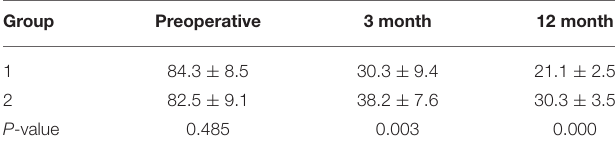
TABLE 3 | ODI of thet two groups